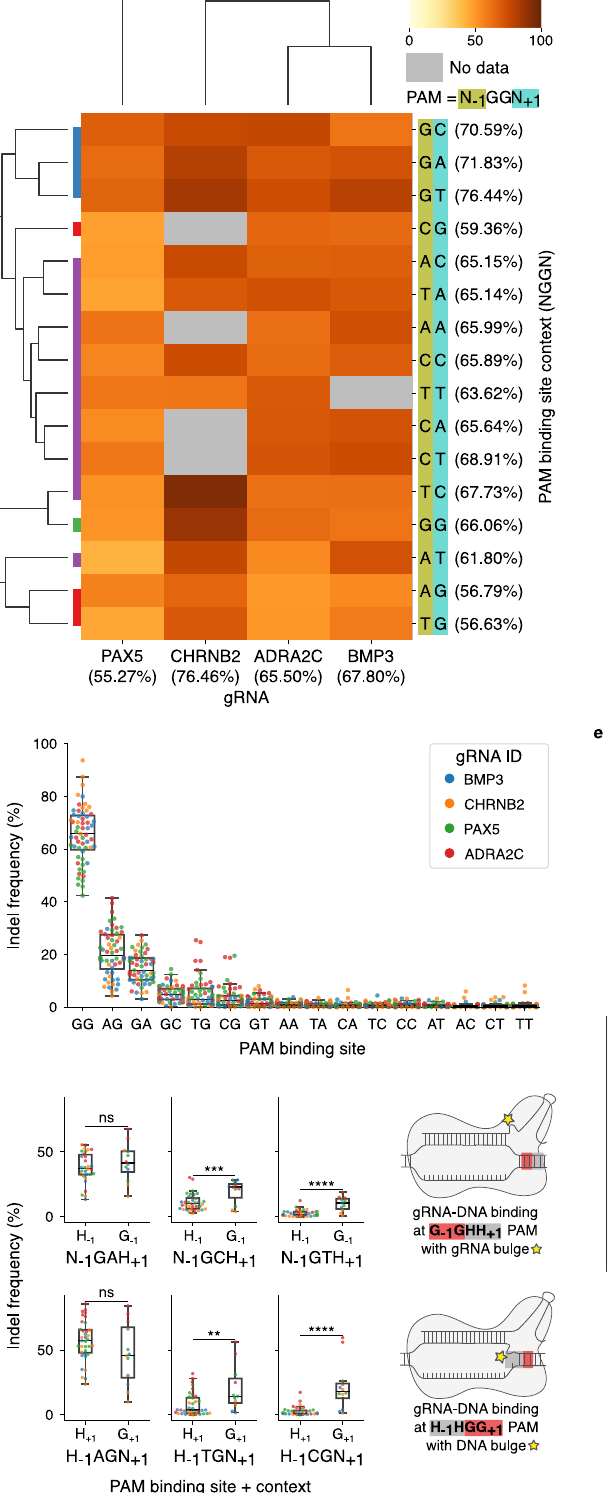
PAMs with binding motif AG and GA, which are the closest to the canonical GG in terms of ef fi ciency, do not display a preference for local sliding toward canonical PAMs. This suggests that fully complementary gRNA – DNA interactions at a non- canonical AG or GA are equally tolerated as bulged bindings at the canonical GG PAM binding site.